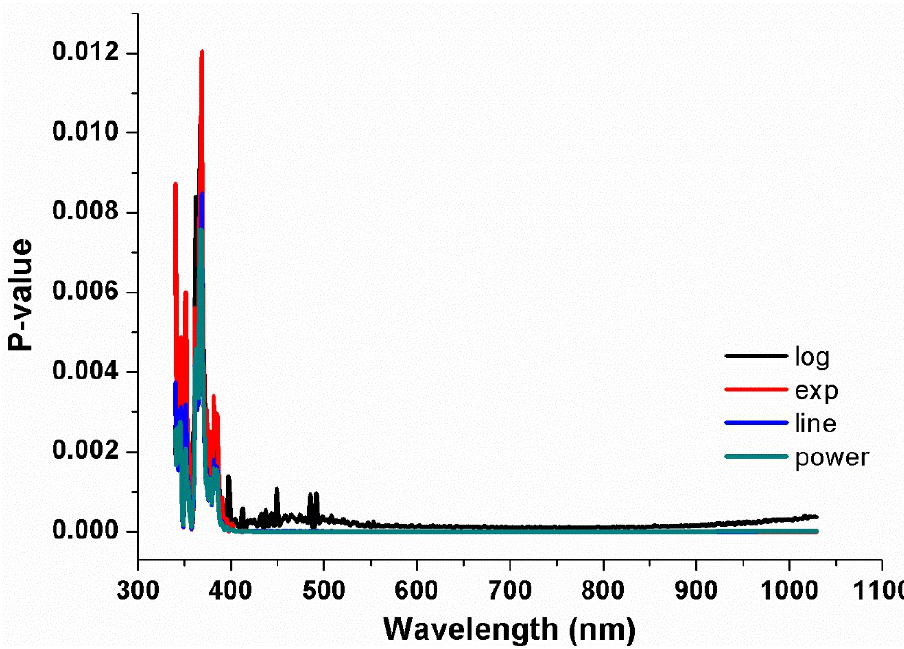
Figure 10. The changes of c orrelation coefficients of the spectral ratio with soil moisture content over wavelength.